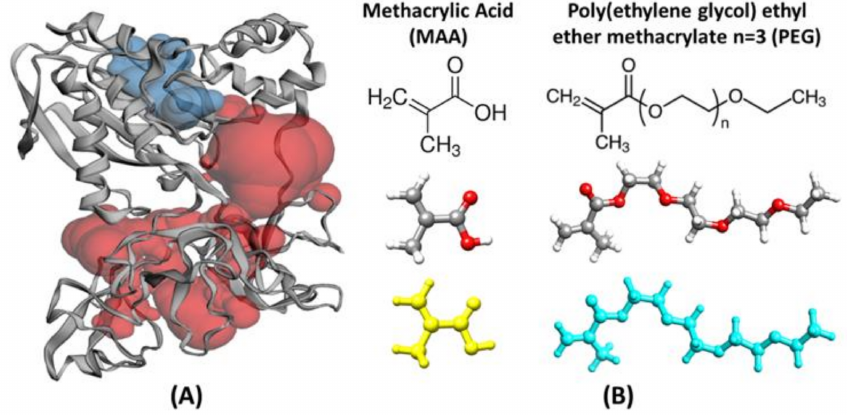
Figure 1. ( A ) Structure of the MMP9 protein extracted from PDB; the ribbon representation of the protein secondary structure is combined with a visualization of the two most significant pockets identified by the CASTp web program [45]. These are the catalytic domain (blue spheres) and the central region of the protein between the catalytic + propeptide domain and the FnII domains; ( B ) structures of the MAA and PEG